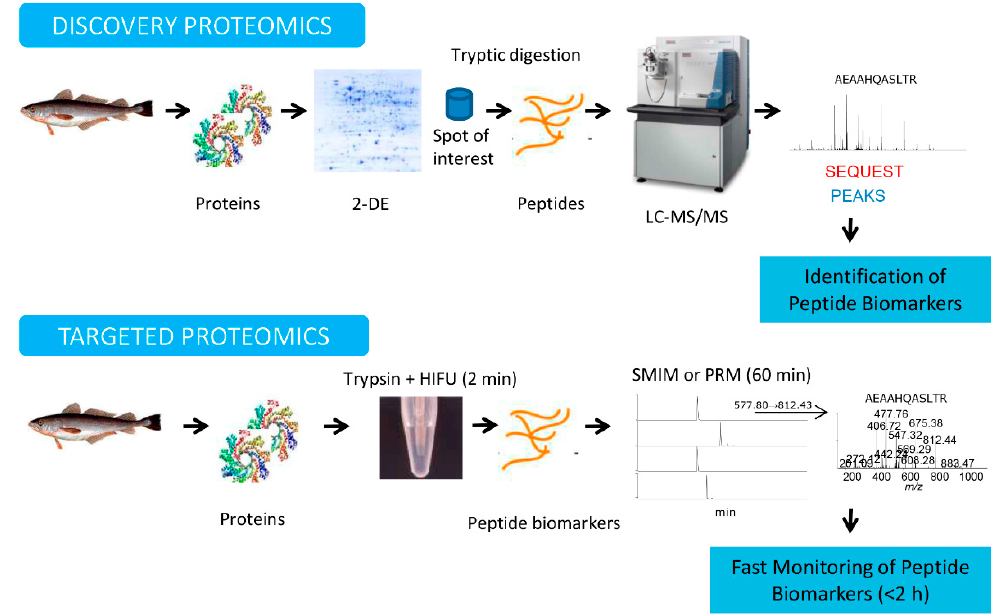
Figure 2. Main proteomics workflows used for the detection and quantification of seafood allergens. Basic workflows used in discovery proteomics and targeted proteomics. In the discovery proteomics approach, a mixture of proteins is separated using two-dimensional gel electrophoresis (2-DE), the spots of interest are in-gel digested with trypsin, the peptides obtained are analyzed using liquid chromatography coupled to tandem mass spectrometry (LC-MS / MS), and the spectra are identified using di ff erent database search engines, such as SEQUEST and PEAKS. Specific peptide biomarkers can be selected. In the fast targeted proteomics approach, the mixture of proteins is in-solution digested with trypsin, accelerated using high-intensity focused ultrasound (HIFU), and then the peptide biomarkers selected in the discovery approach can be monitored using selected MS / MS ion monitoring or parallel reaction monitoring (PRM) during mass spectrometry. The monitoring of peptide biomarkers can be performed in less than 2 h.